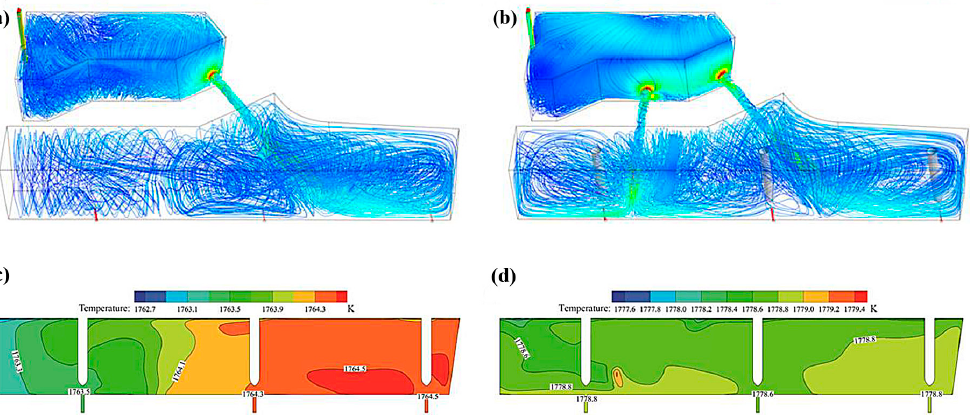
Figure 7. The 3D streamline patterns of molten steel in the tundish and the temperature distribution in the longitudinal section through the outlets of each strand; ( a , c ) are the double channel; ( b , d ) are four channels [66]. © 2022 Wiley-VCH GmbH. All rights reserved.